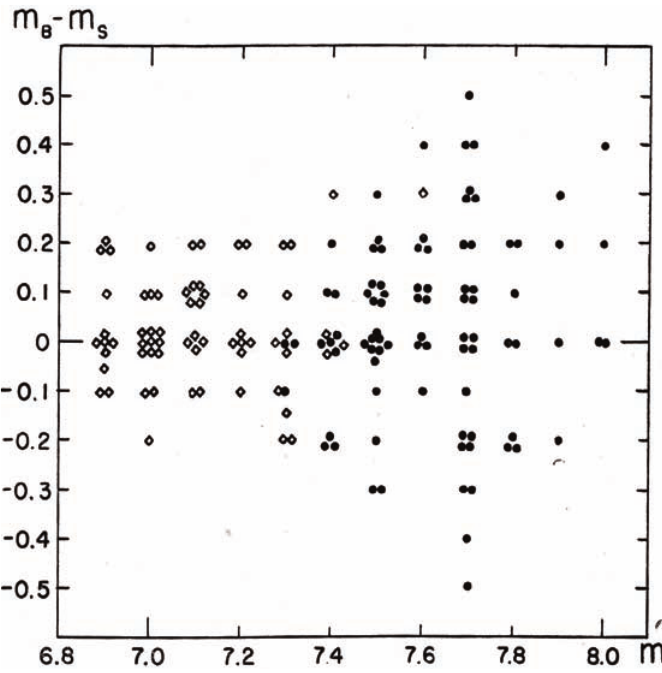
Figure 1. Residuals m – m on the basis a = 0.37, b = 6.76 are plotted against B S m, using amplitude and period data from all available station bulletins.